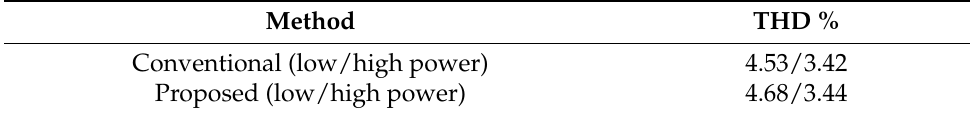
Table 4. THD of the abc currents with the conventional and proposed method.